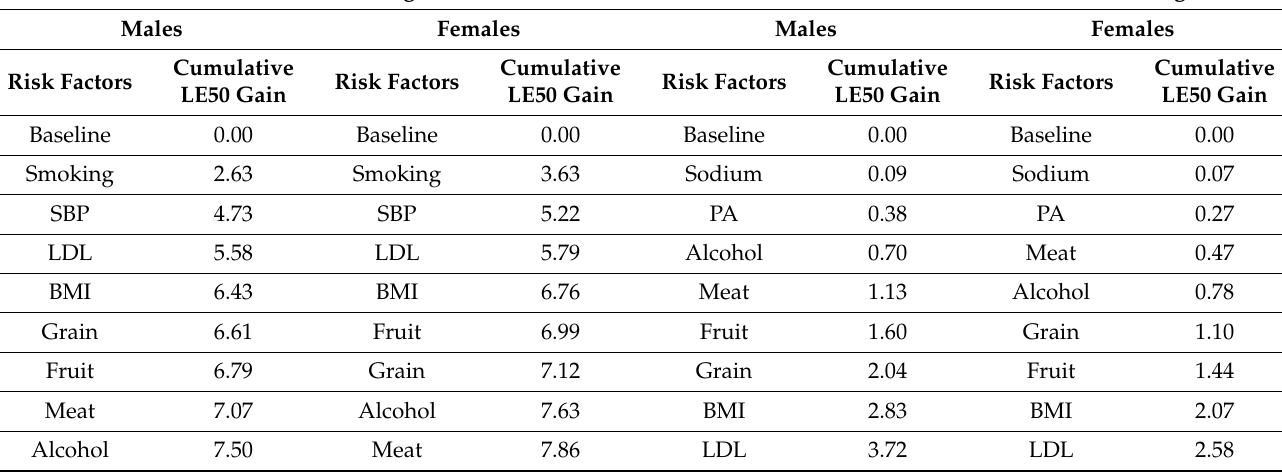
Table 6. An example of cumulative LE50 gains in males and females 50 years of age, resulting from a reduction in exposure to multiple risk factors, considering the levels of other factors and adjusting for